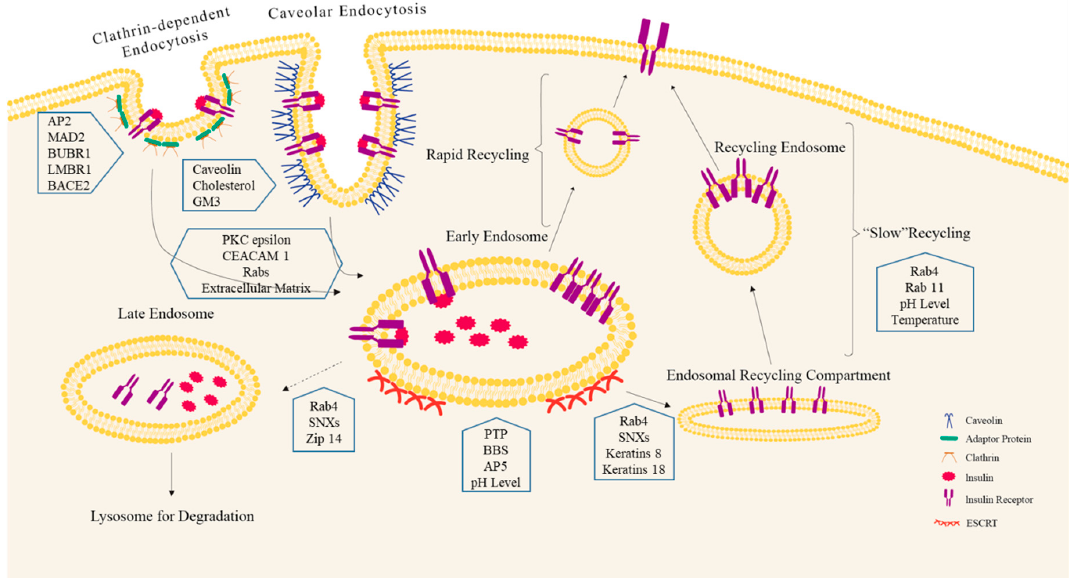
Figure 1. Summary of the existing mechanisms of insulin receptor (INSR) endocytosis,